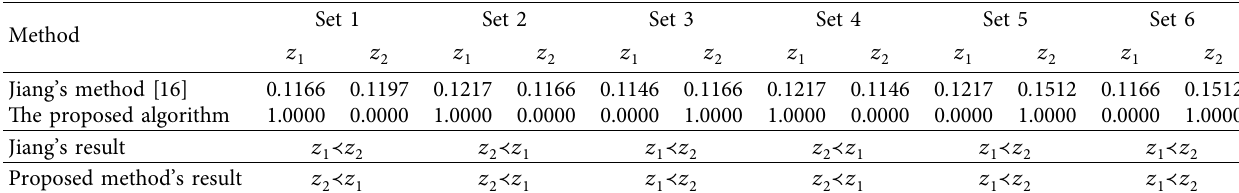
Table 2: A comparison between the ranking of the proposed method and Jiang’s method.